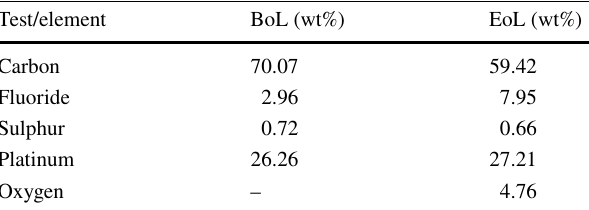
Table 1 Elemental composition of a pristine and tested MEA as obtained from